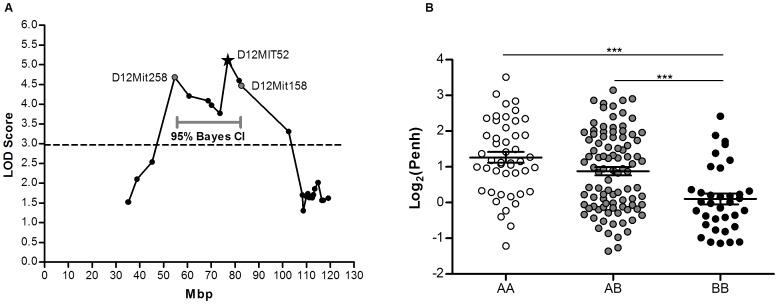
Association of Chromosome 12 markers with airway responsiveness in BcA86 mice.(A) Distribution of LOD scores of markers on Chromosome 12 used to genotype BcA86F2 mice. Dashed line at LOD  = 2.97 represents the 95% LOD threshold for significance generated from 10,000 permutations of randomized associations of the BcA86F2 genotype and phenotype data. Bayes 95% credible interval (CI) was used to determine the QTL confidence interval delimited by markers (grey dots) D12Mit285 at 54.6 Mbp (LOD score  = 4.68) and D12Mit158 at 82.6Mbp (LOD score  = 4.47). The most significant marker in the region is D12Mit52 (★) at 77.0Mbp with a LOD score of 5.11 and p = 3.68×10−3. (B) Distribution of log2(Penh) among the three possible genotypes at D12Mit52 (AA = homozygous for A/J, BB = homozygous for C57BL/6J and AB = heterozygous). Groups with A/J genotype at D12Mit52 (AA and AB) have significantly greater mean log2(Penh) value than homozygous C57BL/6J group (BB) (AA: 1.264 ± 0.151, AB: 0.879 ± 0.114, and BB: 0.102 ± 0.157). Data are presented as mean ± SEM and *** represents p<0.001 from one-way ANOVA and Bonferroni correction.